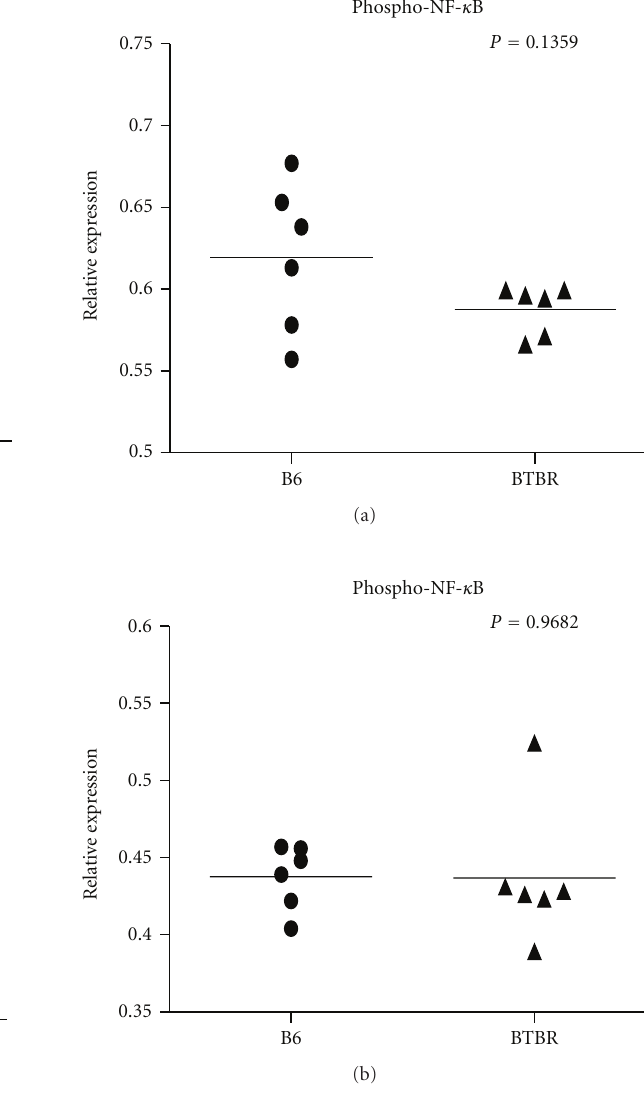
Figure 4: Phospho-NF- κ B p65 concentration in the cerebellum and cortex of autistic subjects. Measurement of phospho-NF- κ B p65 in the cerebellum ((a) P = 0 . 966) and cortex ((b) P = 0 . 535) of six autistic subjects and six age-matched controls with ELISA.